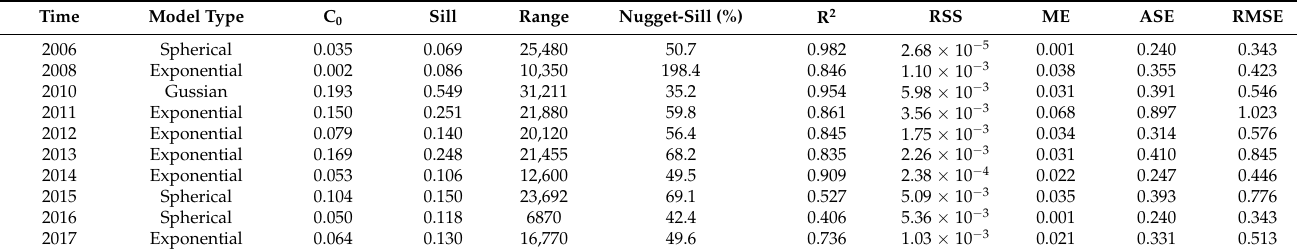
Table 3. Parameters of Semi-variogram models for soils salinity in survey